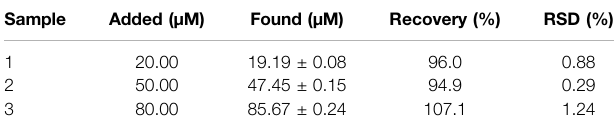
TABLE 1 | Determination of ACV in commercial ACV tablet samples ( n = 3).